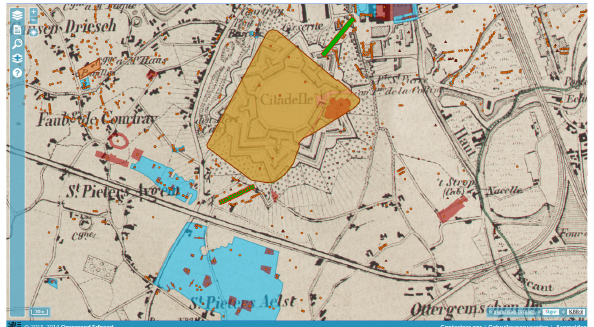
Figure 3: Different types of heritage in Gent as projected on the Vandermaelen map